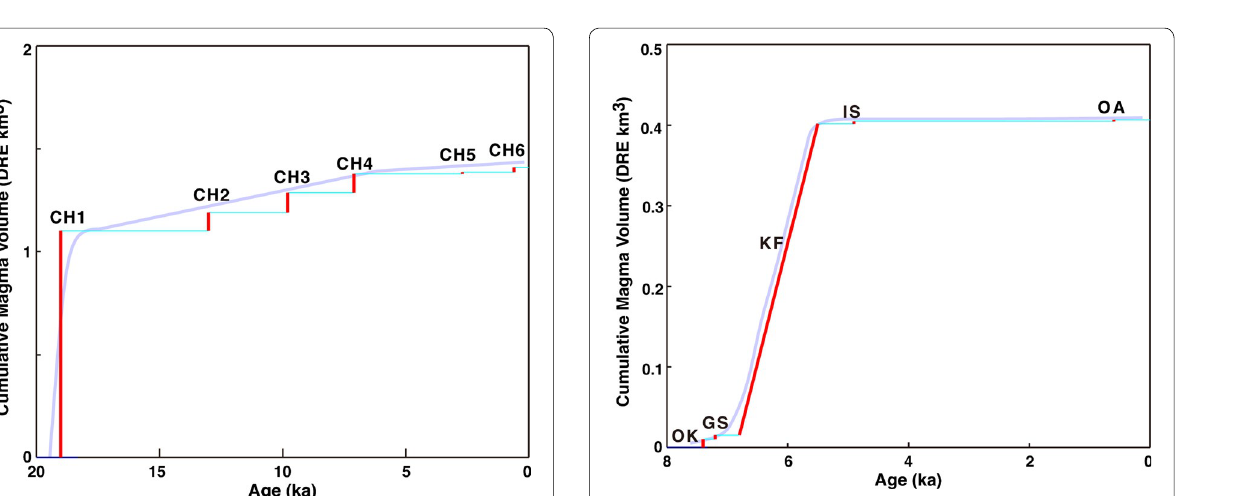
Okenuma unit; = Kofuji unit; IS Issaikyo unit; OA Oana = = =